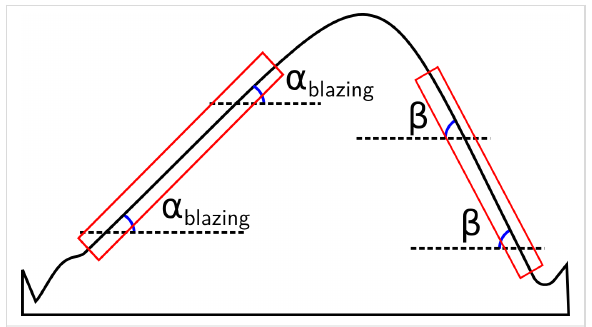
Figure 2: 2D saw-tooth sketch showing the blazing angle α and the back angle β . Measurements are confined to the linear area of the slopes (red rectangles), where the angles are supposedly